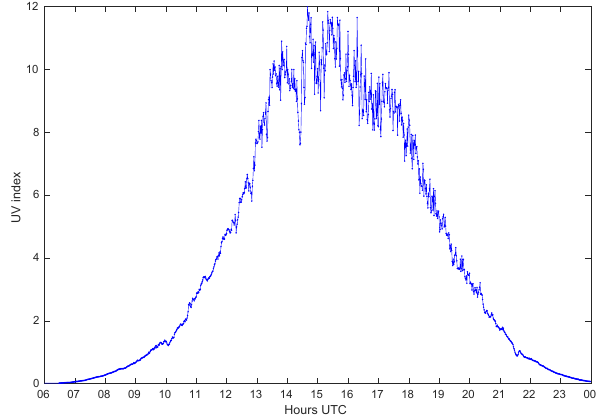
Figure 6. UV indices measured by the NILU-UV radiometer at Marambio on the day of the record high UV index on 18 November